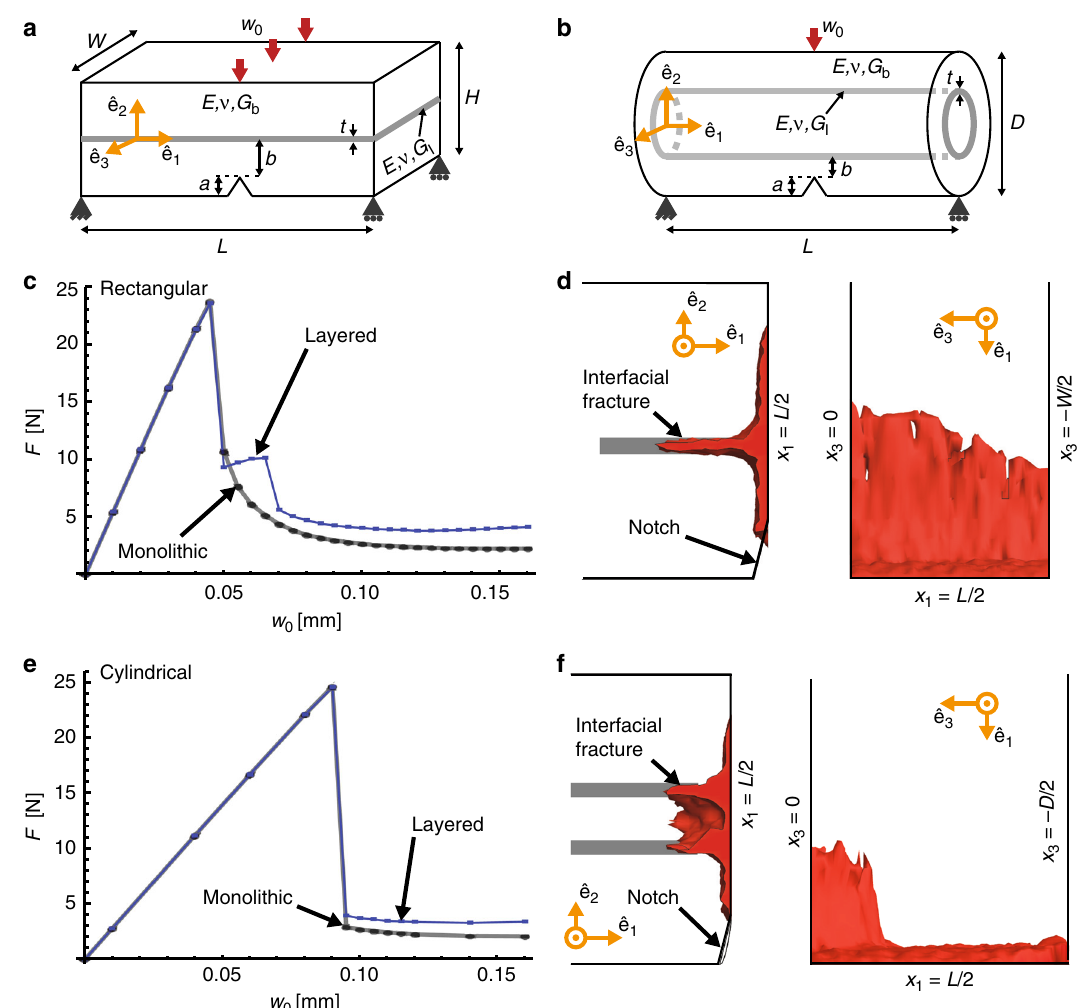
Fig. 9 Regularized variational fracture model of beams with planar and cylindrical layered architectures. a Geometry of the notched layered beam with one planar interlayer shown in gray. b Geometry of the notched cylindrical layered beam with one cylindrical interlayer shown in gray. c Load displacement ( F - w 0 ) response of the planar layered beam loaded in three-point bending. d Crack paths in the planar layered beam as seen from the planes whose normal vectors are ^ e 3 and ^ e 2 . The red region corresponds to the crack path predicted by the RVF calculations at a displacement w 0 = 0.16 mm. e F - w 0 response of the cylindrical layered beam loaded in three-point bending. f Crack paths in the cylindrical layered beam as seen from the planes whose normal vectors are ^ e ^ e 3 and 2 . The red region corresponds to the crack path predicted by the RVF calculations at a displacement w 0 e correspond to monolithic beams with the same geometry and bulk